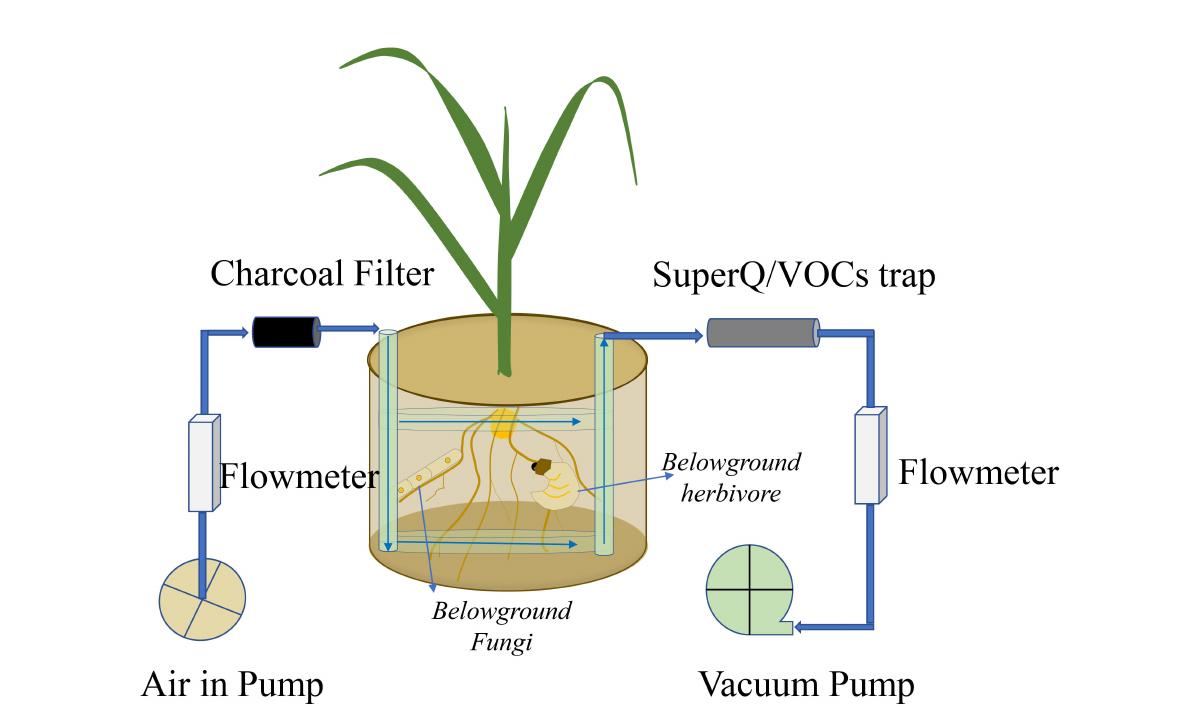
FIGURE 2 Volatile organic compound (VOC) emissions from roots, soilborne organisms, and soil matrix are collected by a push – pull system. The VOCs are trapped by a Super-Q trap.